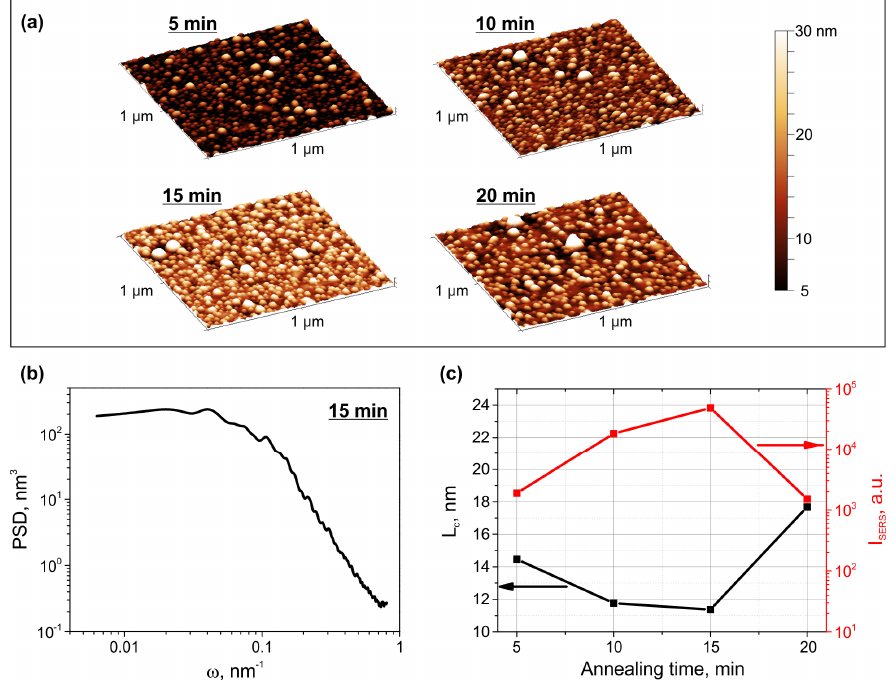
Figure 5. ( a ) AFM images of SNF formed at different annealing time (denoted). ( b ) PSD function of the AFM image of the 15-min sample. ( c ) The dependencies of integral intensity of 1200 cm − 1 BPE Raman peak enhanced by SNFs (right axis, red curve) and SNFs’ correlation length (left axis, black curve) on the annealing time.